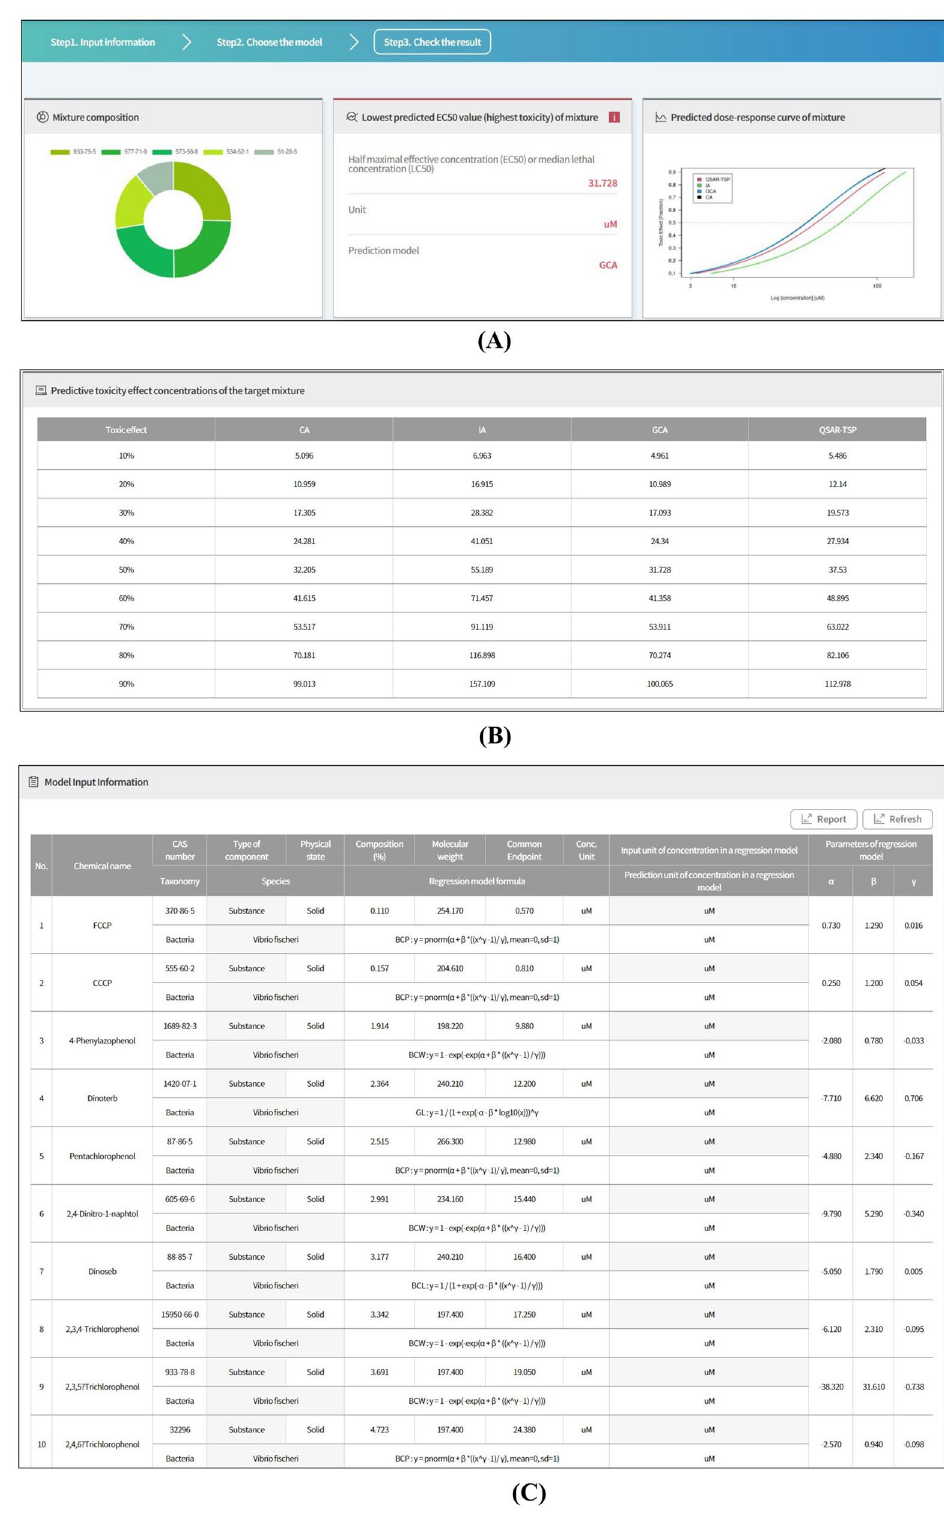
Figure 5. MRA Toolbox GUI for reporting prediction results. ( A ) Graphical information for mixture composition; representative EC 50 as lowest value and DRCs of target mixture predicted by selected models; ( B ) toxicity effects (%) vs. effective concentrations computed by models; and ( C ) user input data for all mixture